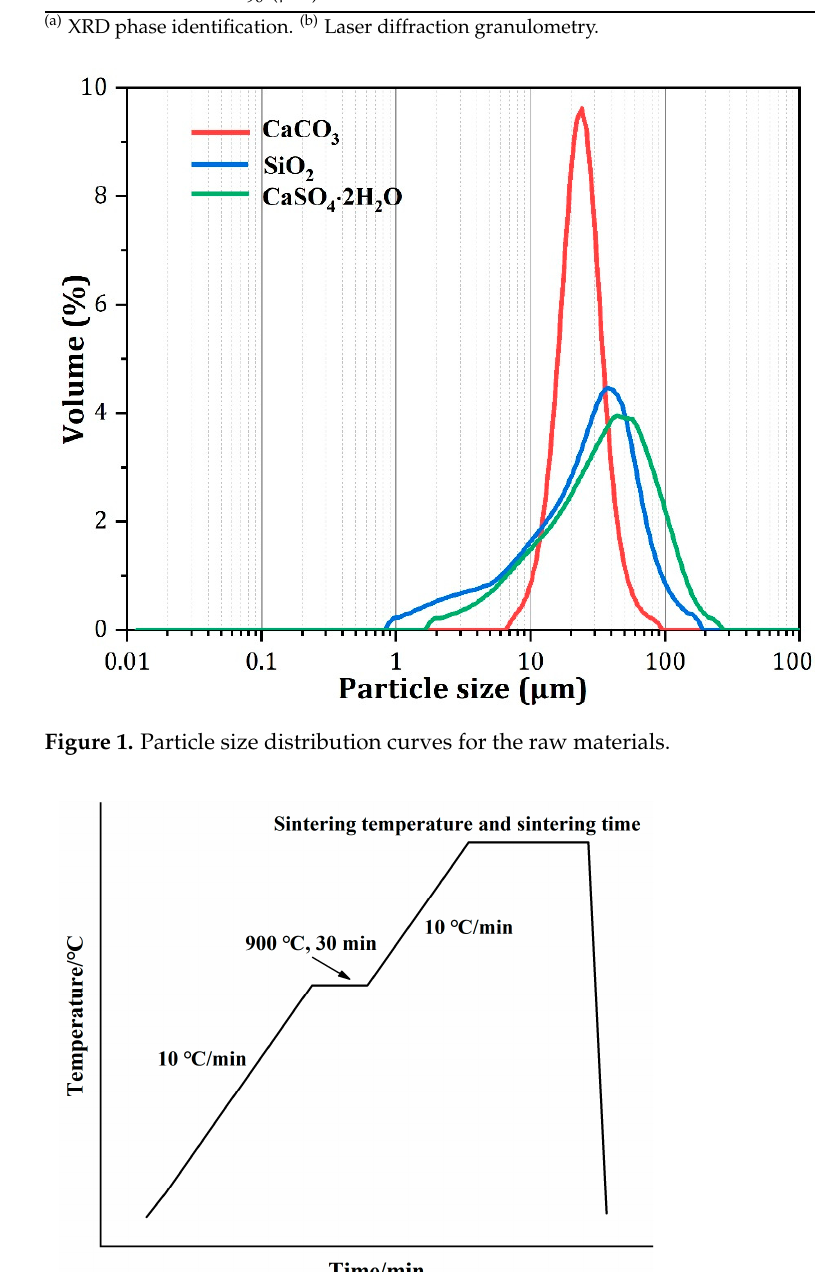
Table 2. Physical characteristics of the raw materials. Raw Material Calcium Carbonate Quartz Calcium Sulfate Dihydrate Mineralogical analysis (a)